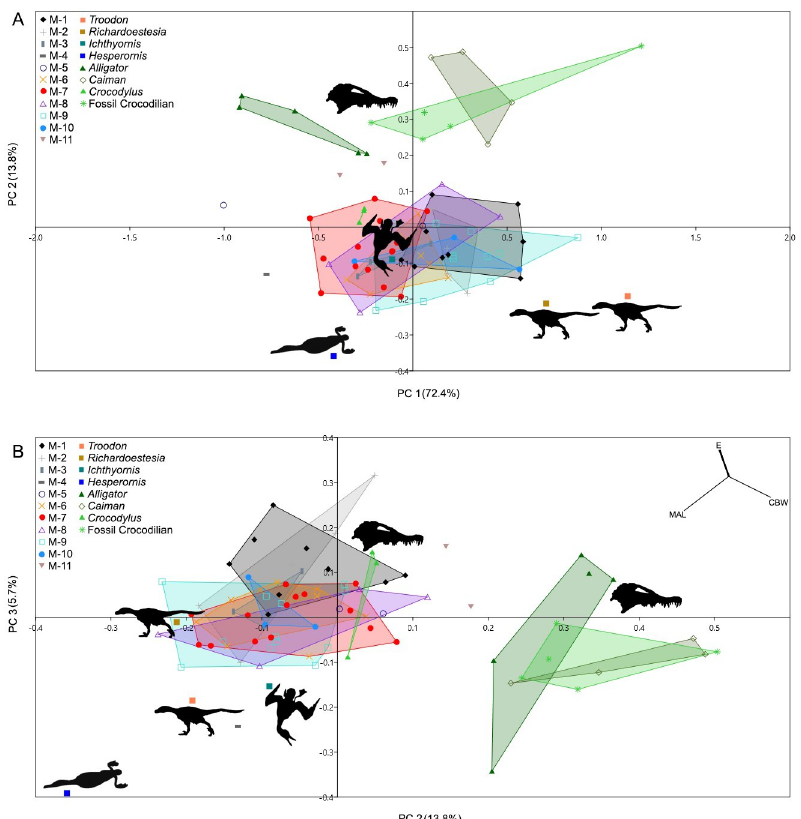
Fig 5. Principal Component Analysis of putative avian teeth morphotypes, selected non-avian theropod and bird teeth, and fossil and modern crocodilian teeth. A , Principal Component 1, x axis, Principal Component 2, y axis; B , Principal Component 2, x axis, Principal Component 3,y axis; Convex hulls are included around Morphotypes and taxa. Top right corner shows vectors for the following variables; CBW, crown basal widths; E, variables including AD, CH, BC, FABL; MAL, mesial apical